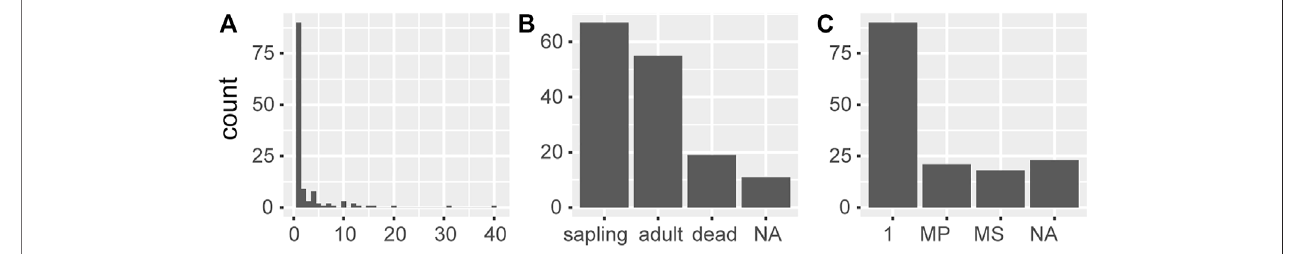
FIGURE 4 | Demographics of the population (A) number ofrosettes (B) life stage and (C) growth form according to rosettes (MP = multiple primary; MS = multiple secondary). NA denotes missing data.